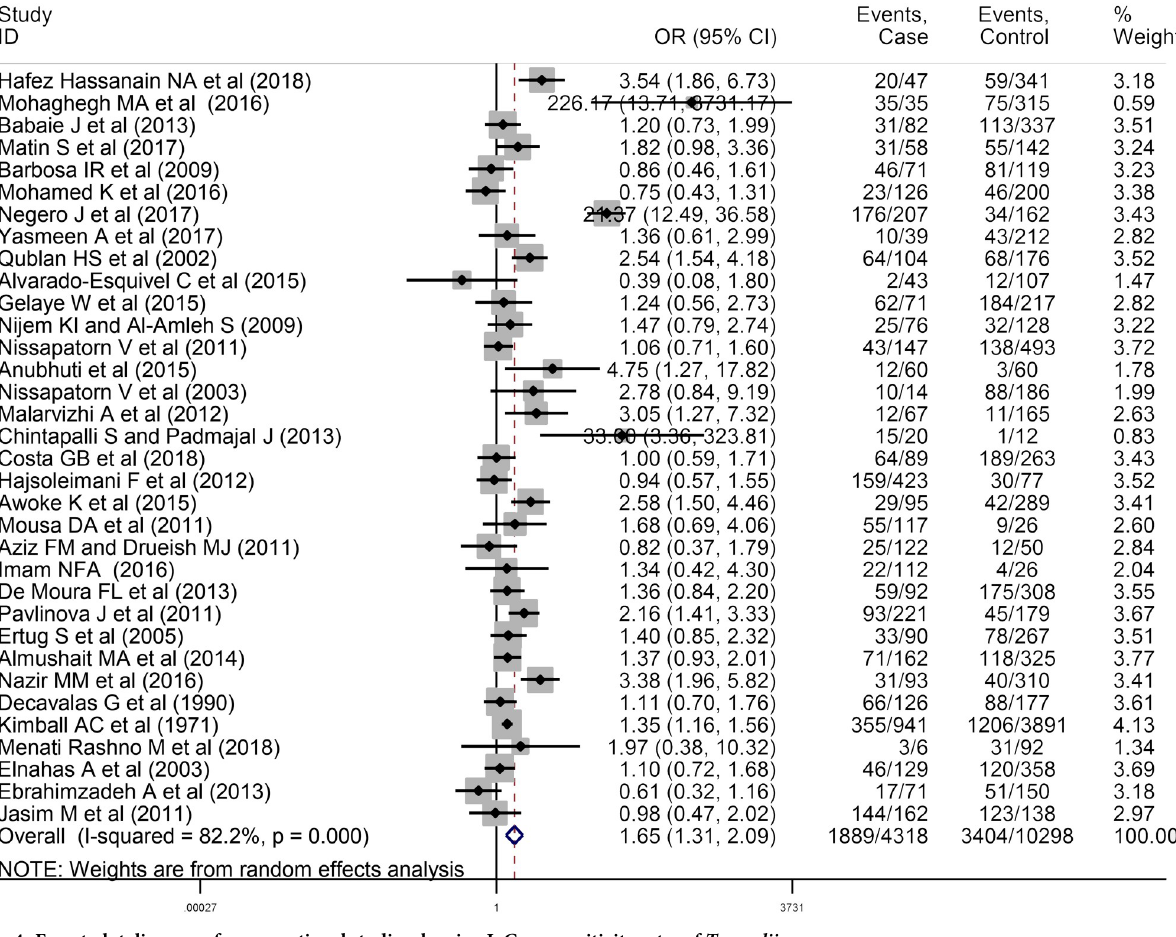
Fig 4. Forest plot diagram of cross-sectional studies showing IgG seropositivity rates of T . gondii .